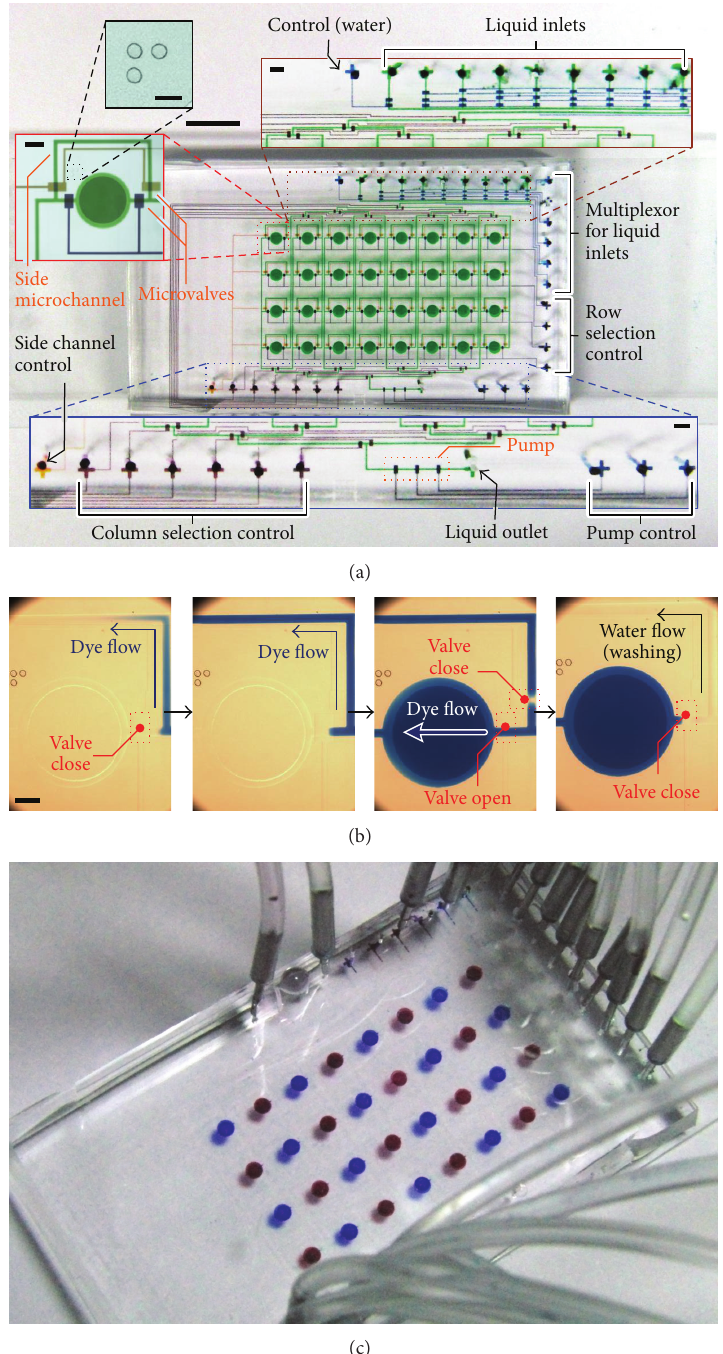
Figure 2: (a) Device configuration of a 32-chamber device. The channels have been filled with dyes for better visualization. Left inset (scale bar: 500 𝜇 m): microchamber region including an alignment mark ( upper left inset; scale bar: 250 𝜇 m), a side channel with its control valves, andtherow-selectionvalves.Thedarkercircleinthechamberindicatesadeepermicrowell. Upper inset(scalebar:500 𝜇 m):liquidmultiplexor for selection of one inlet liquid from a total of eight choices and upper multiplexor for column selection. Lower inset (scale bar: 500 𝜇 m): lowermultiplexorforcolumnselection,sidechannelcontrol,peristalticmicropump,andliquidoutlet.Scalebarinthewhole-chipphotograph represents a length of 5 mm. (b) Procedures of dye injection into a chamber and the following washing step. Scale bar: 250 𝜇 m. (c) A checker pattern of dyes with two different colors injected in the microfluidic